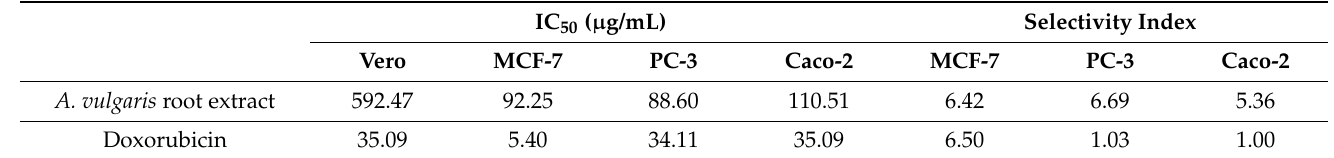
Figure 3. Morphology of MCF-7, PC-3, Caco-2 and Vero cells after 48 h from the treatment with different concentrations of A. vulgaris root extract. Pictures were taken using a Reichert-Jung in- verted biological microscope, series 1820 Biostar with a 10× objective coupled with MEM1300 mi- croscope USB digital camera. Table 6. IC 50 ( µ g/mL) and selectivity index of A. vulgaris root extract against different cell lines. IC 50 ( µ g/mL)